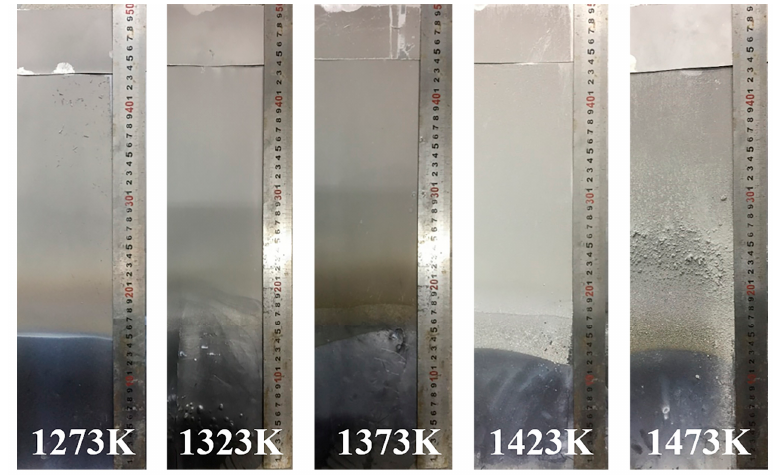
Figure 3. Condensation phenomenon of Mg vapor (1273–1473 K).